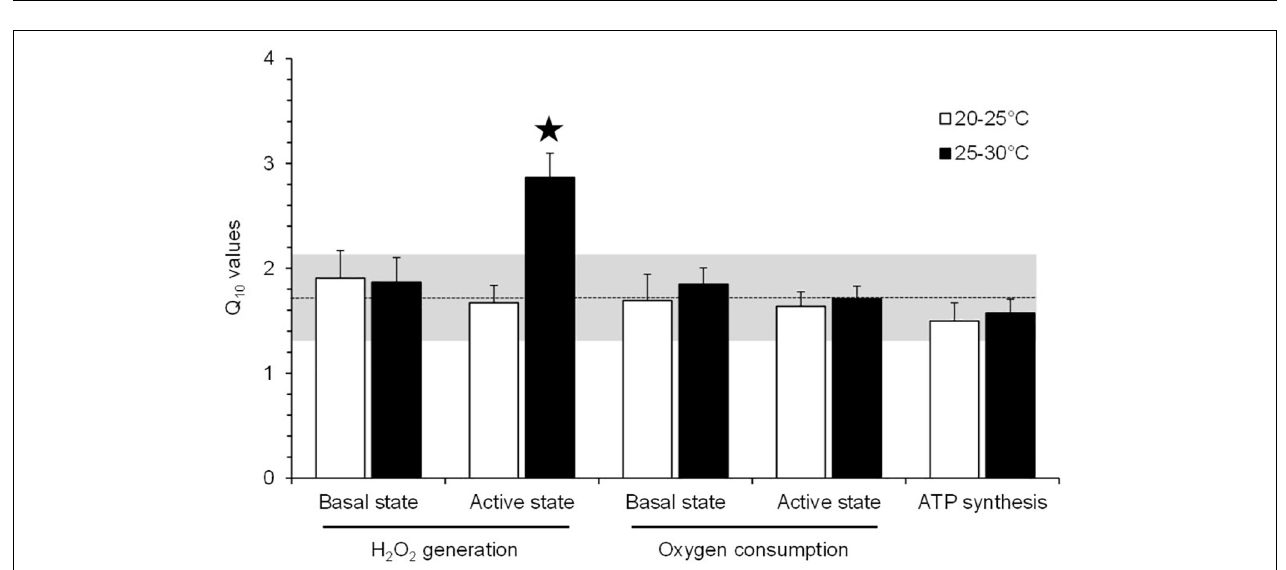
FIGURE 5 | Q 10 values for the effect of acute temperature change on the mitochondrial parameters of toad liver. The values are means ± SEM for N = 5 independent mitochondrial preparations. *Significantly different from all of the other Q 10 values ( p < 0.05). The dashed line represents the mean of Q 10 values for all mitochondrial parameters ( ± SD is represented by the horizontal gray-shaded rectangle), excluding the Q 10 ( 25 − 30 ◦ C ) value for the H 2 O 2 production under an active phosphorylating